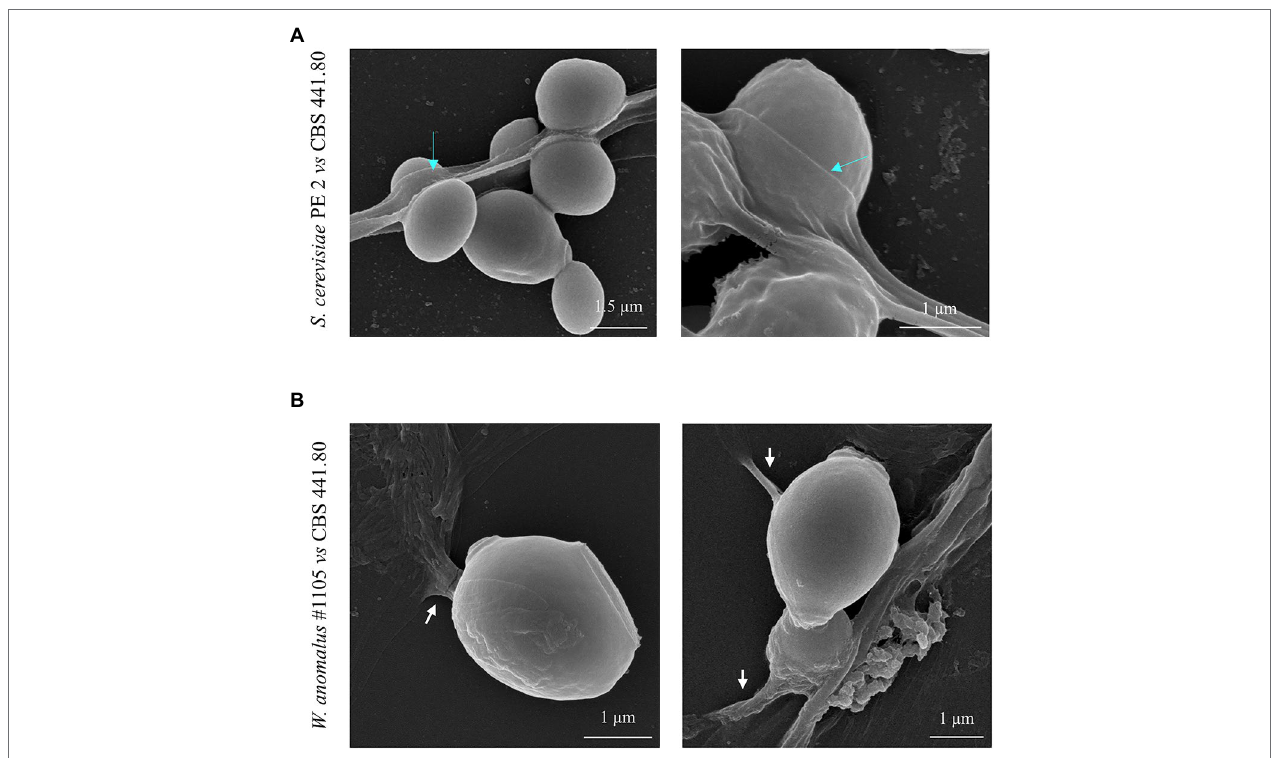
FIGURE 6 | SEM micrographs of the yeast/filamentous fungal strains combinations (A) S. cerevisiae PE2 vs. M. perniciosa CBS 441.80 and (B) W. anomalus #1105 vs. M. perniciosa CBS 442.80, showing in detail the occurrence of the veil covering the yeast cells (blue arrows), and the apparent tube-like structures ligating yeasts to hyphal contents (white